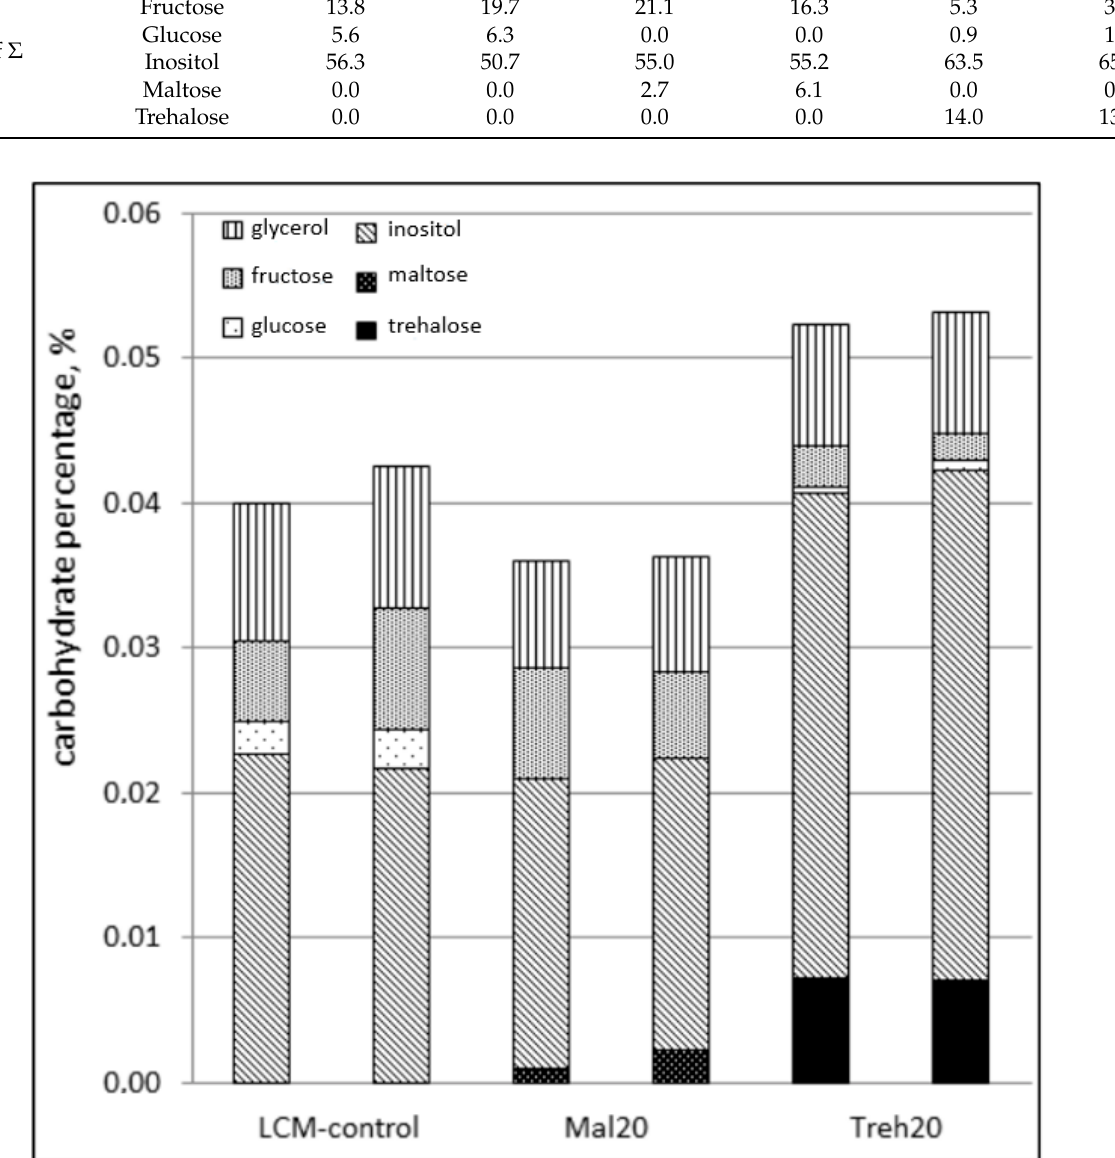
Figure 1. Carbohydrate composition of spermatozoa cytosol in native rooster semen after equilibration with cryoprotective diluents (freezing protocol is presented in Section 4.3; composition of diluents LCM control, Mal20, and Treh20 is presented in Table 5; evaluation of each sample was carried out in